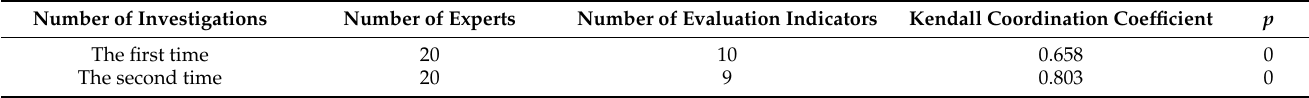
Table 5. Kendall coordination coefficient analysis